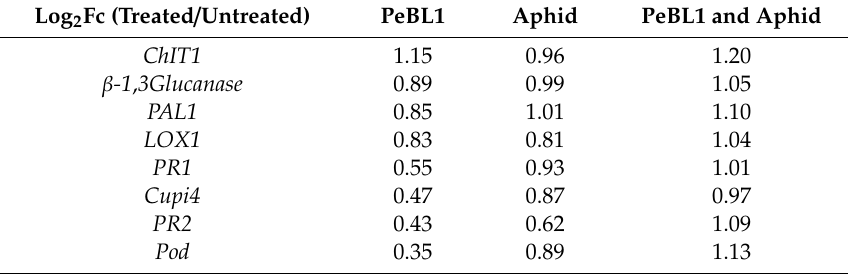
Table 4. Log 2 of fold change expressions all test genes involved in the JA, SA, and ET pathways after the PeBL1 elicitor application, PeBL1 and aphid, and aphid infestation alone. Log 2 Fc (Treated / Untreated) PeBL1